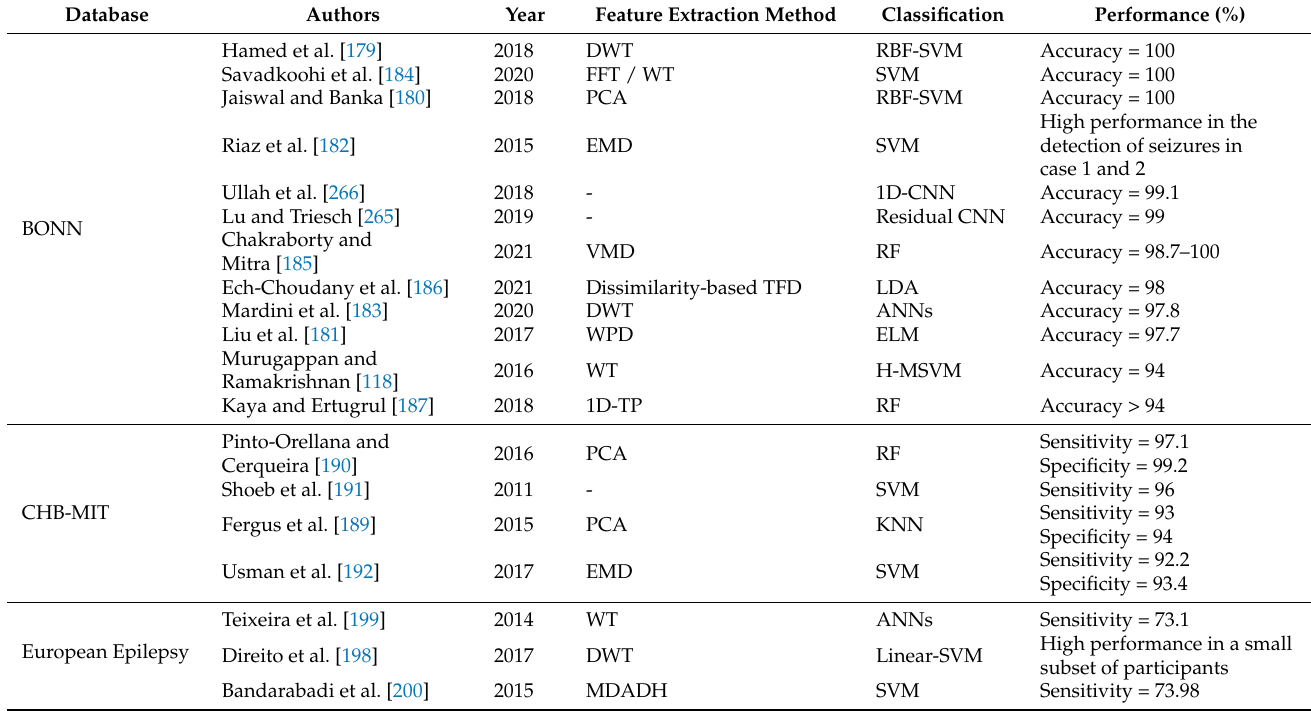
Table 5. Comparison of studies conducted for the seizure detection task by using shared data